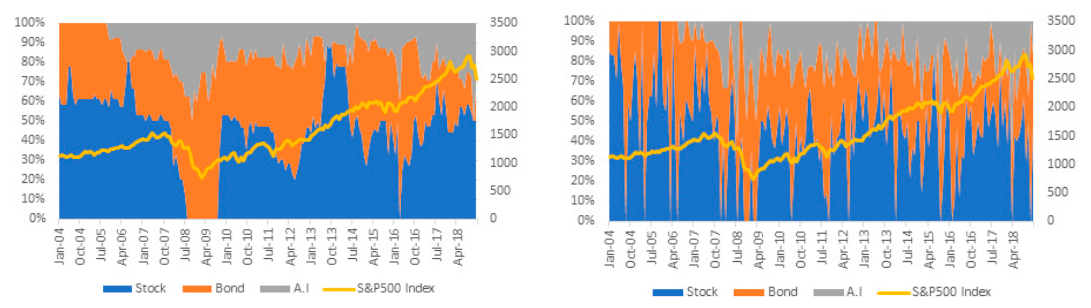
Figure 8. Change of Weights in Asset 10.